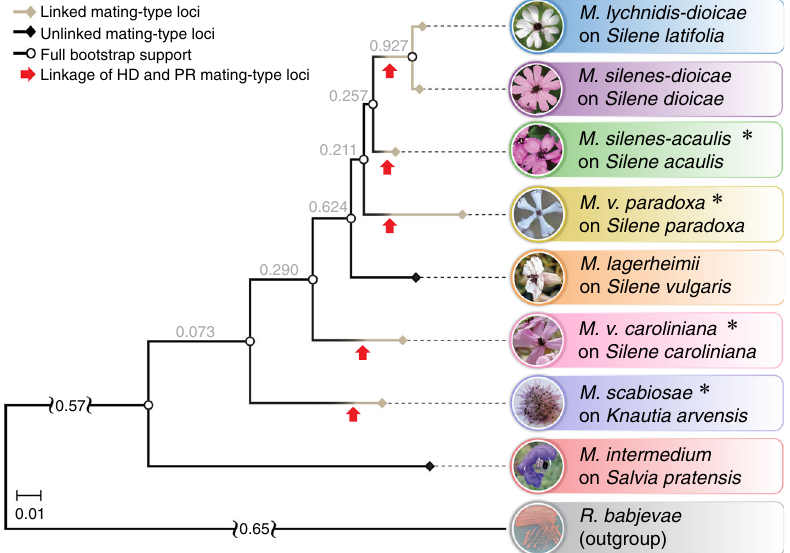
Fig. 1 Phylogenies of anther-smut fungi and their breeding systems. Phylogenetic tree of the studied Microbotryum species (shown in the anthers of their host plants) and the outgroup Rhodotorula babjevae , based on 4229 orthologous genes. Species whose genomes were obtained in the present study are indicated by asterisks. Branch color and symbol indicate linked (gray branches and diamonds) or unlinked (black branches and diamonds) mating-type loci. The white circles indicate full bootstrap support. Red arrows indicate independent mating-type locus linkage events. Tree internode certainty with no con fl ict bipartitions (the normalized frequency of the most frequent bipartition across gene genealogies relative to the summed frequencies of the two most frequent bipartitions) is provided below the branches, indicating good support for the nodes. Relative certainty for this tree is